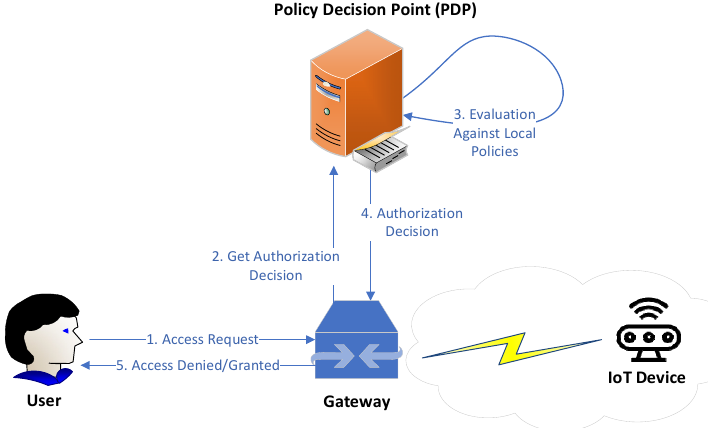
Figure 7. Centralized Approach [48].